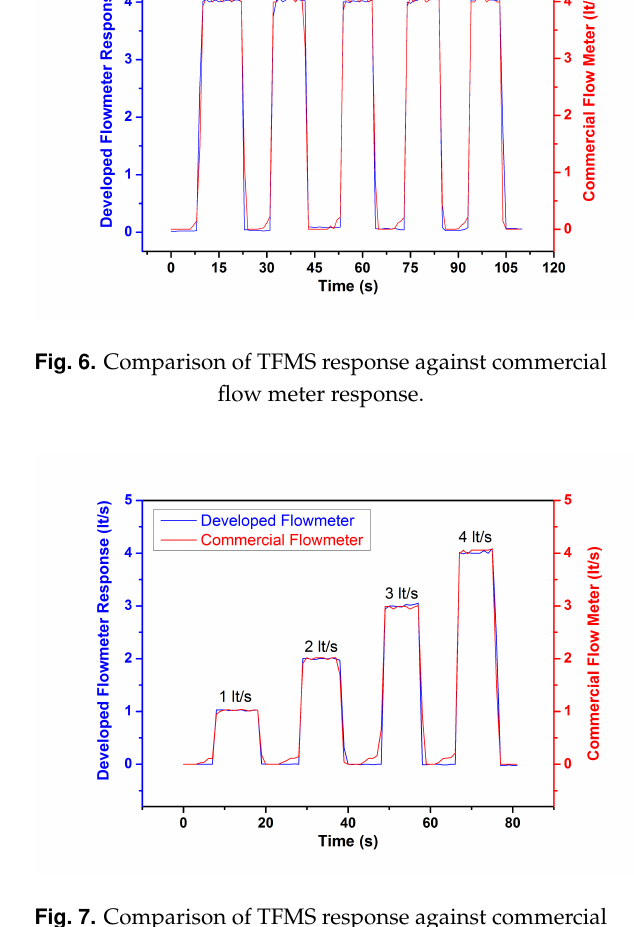
Fig. 7. Comparison of TFMS response against commercial flow meter response for varying flow rates.